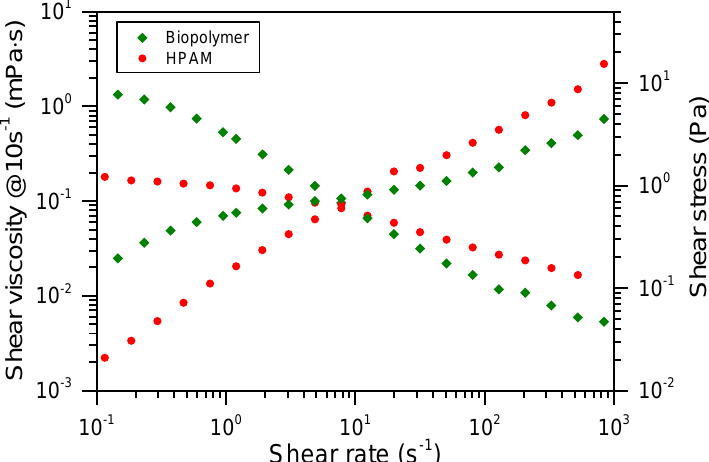
Figure 4. Rheological properties of the polymer systems. Table 3. Fitting parameters for the biopolymer and HPAM. Shear Viscosity Shear Polymer